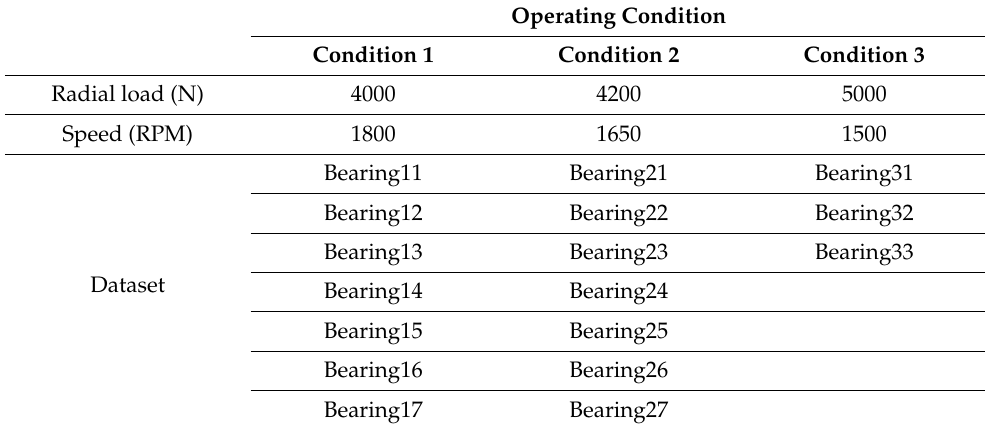
Table 1. FEMTO bearing dataset [27] .